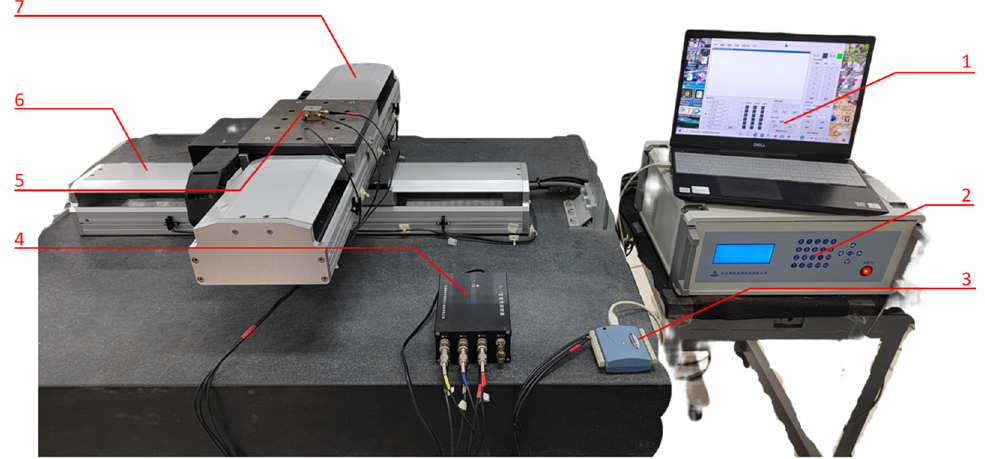
Figure 7. X-Y two-axis linkage linear motor feeding system experimental platform. Table 2. Numbers and names of acquisition devices.